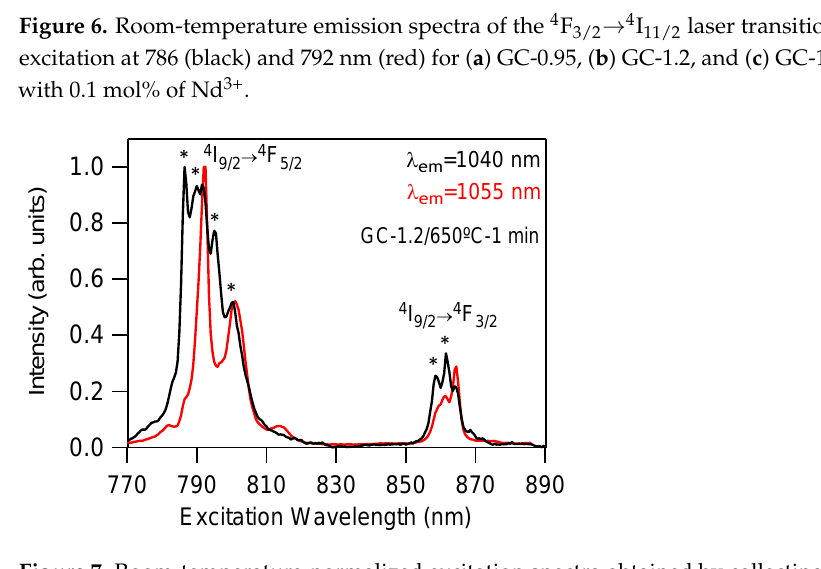
Figure 7. Room-temperature-normalized excitation spectra obtained by collecting the luminescence at 1040 and 1055 nm for the GC-1.2 sample doped with 0.1 mol% of Nd 3+ (*) symbols correspond to LaF 3 crystalline phase.